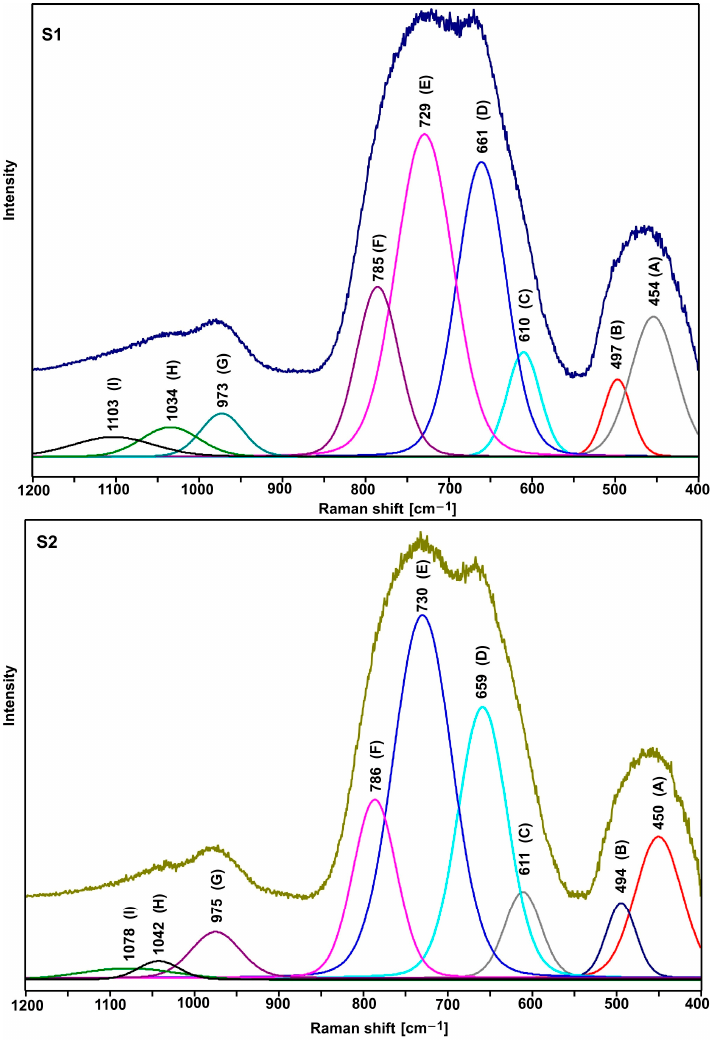
Figure 5. Deconvoluted Raman spectra of S1 and S2 glasses.